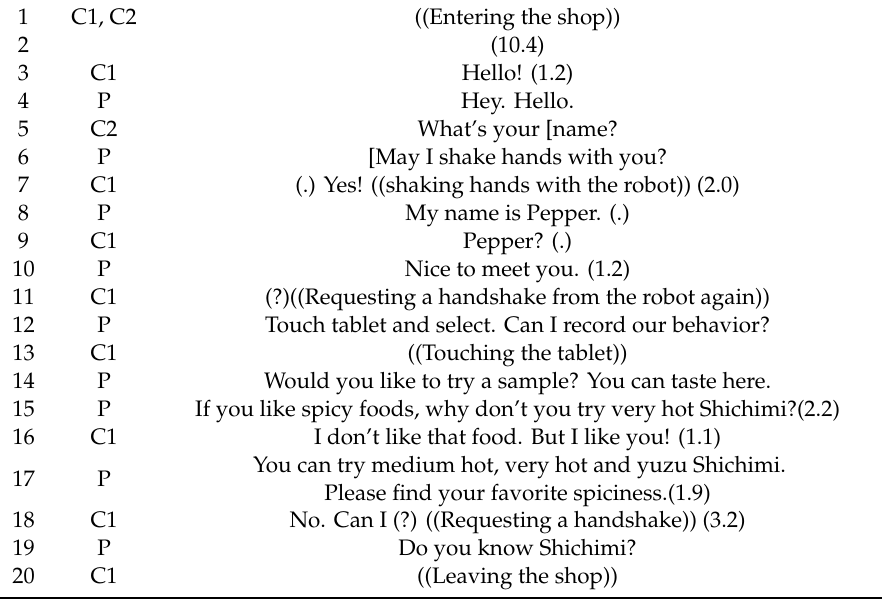
Table 12. Conversation with a group whose behavior did not match the model (21 November